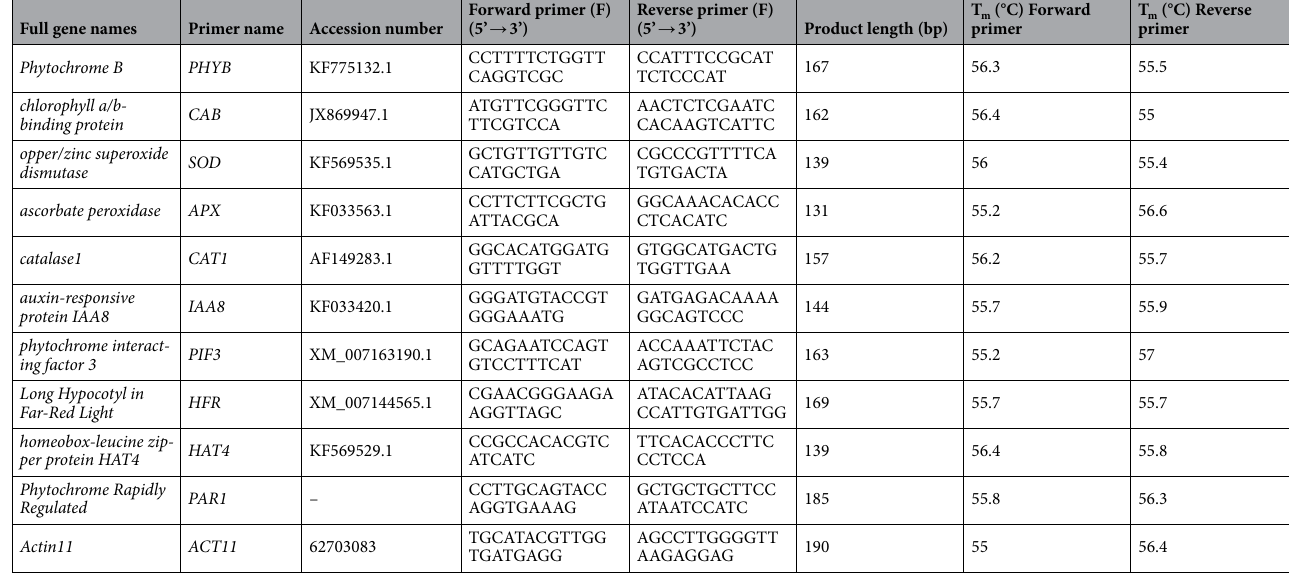
Table 2. Primers characteristics used in the